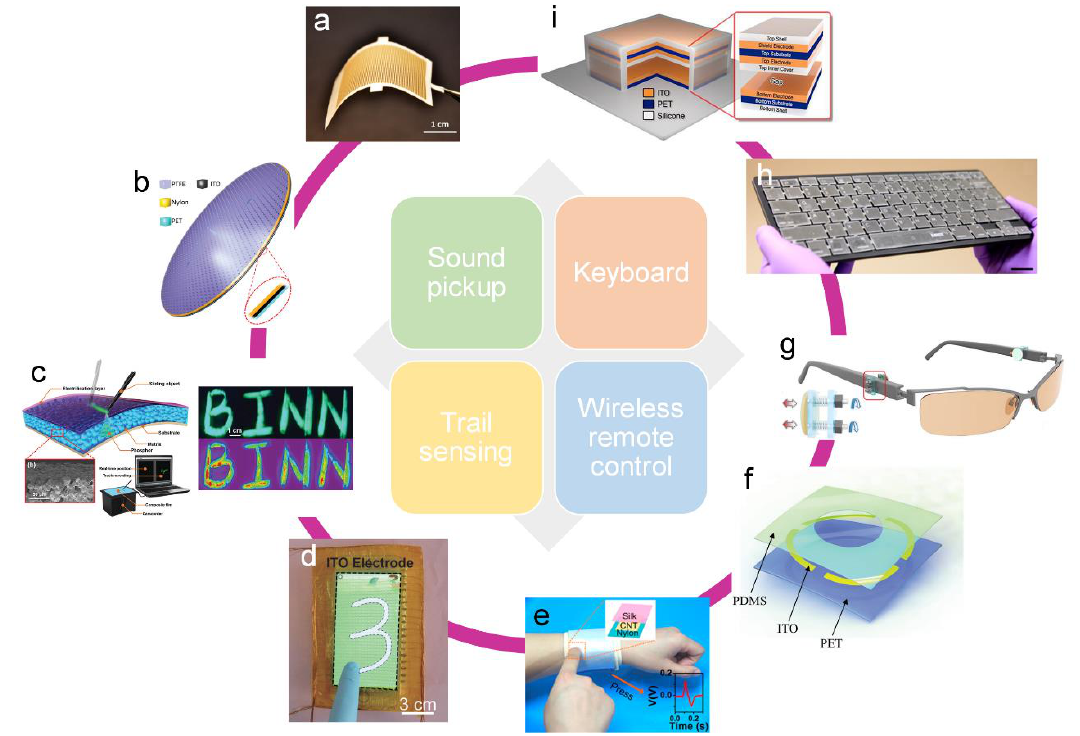
Figure 15. TENGs for human–machine interface applications. ( a ) A paper-based TENG for